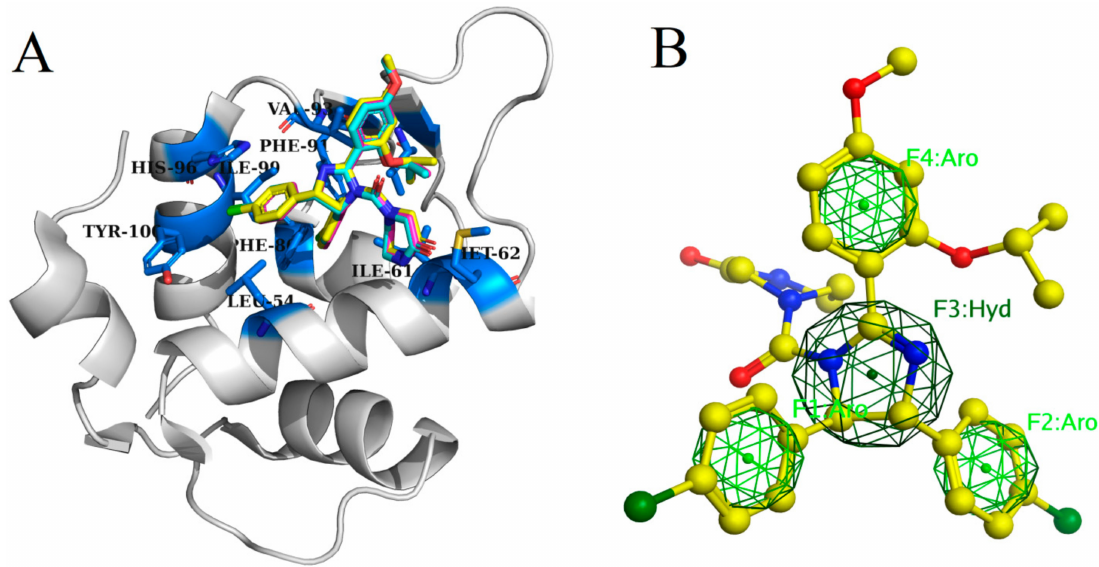
Figure 1. ( A ) Binding of all ligands inside the binding pocket of MDM2, ( B ) 3D representation of pharmacophore features model used to search against the terpenes